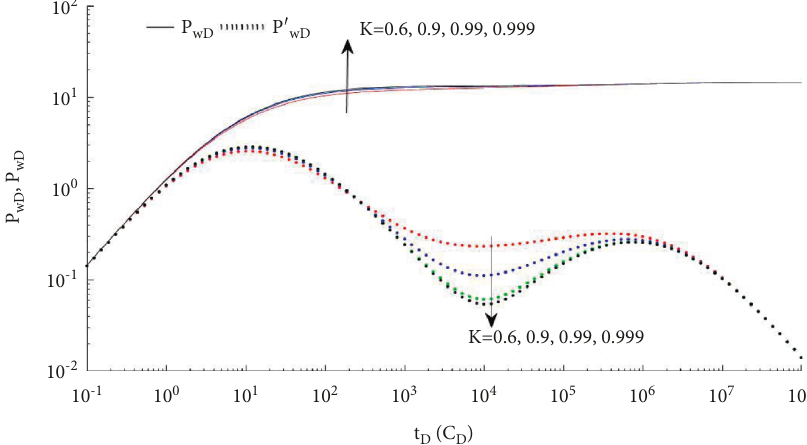
Figure 7: Dimensionless pressure of vertical wells under the close boundary influenced by K ( C